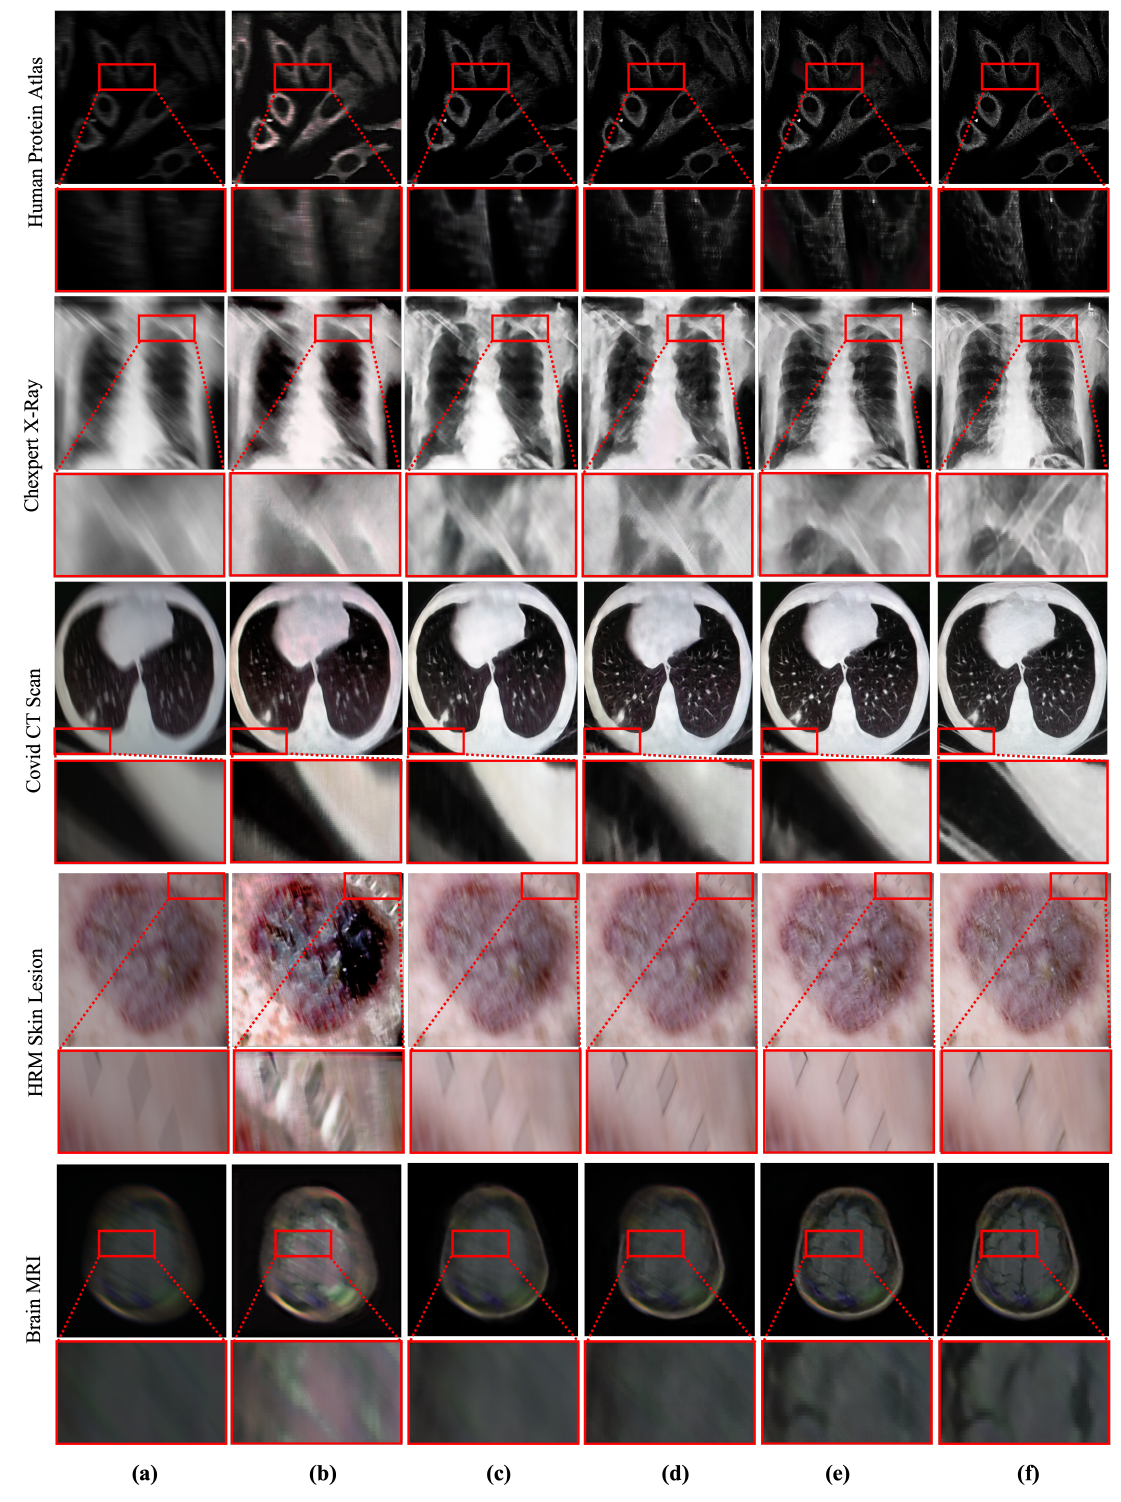
Figure 5. Qualitative comparison between deep MID methods. The proposed method outperforms the existing methods by recovering salient information from blurry medical images. ( a ) Blurry input. ( b ) Result obtained by TEMImageNet [9]. ( c ) Result obtained by ZhaoNet [11]. ( d ) Result obtained by Deep Deblur [12]. ( e ) Result obtained by SRN Deblur [13]. ( f ) Proposed